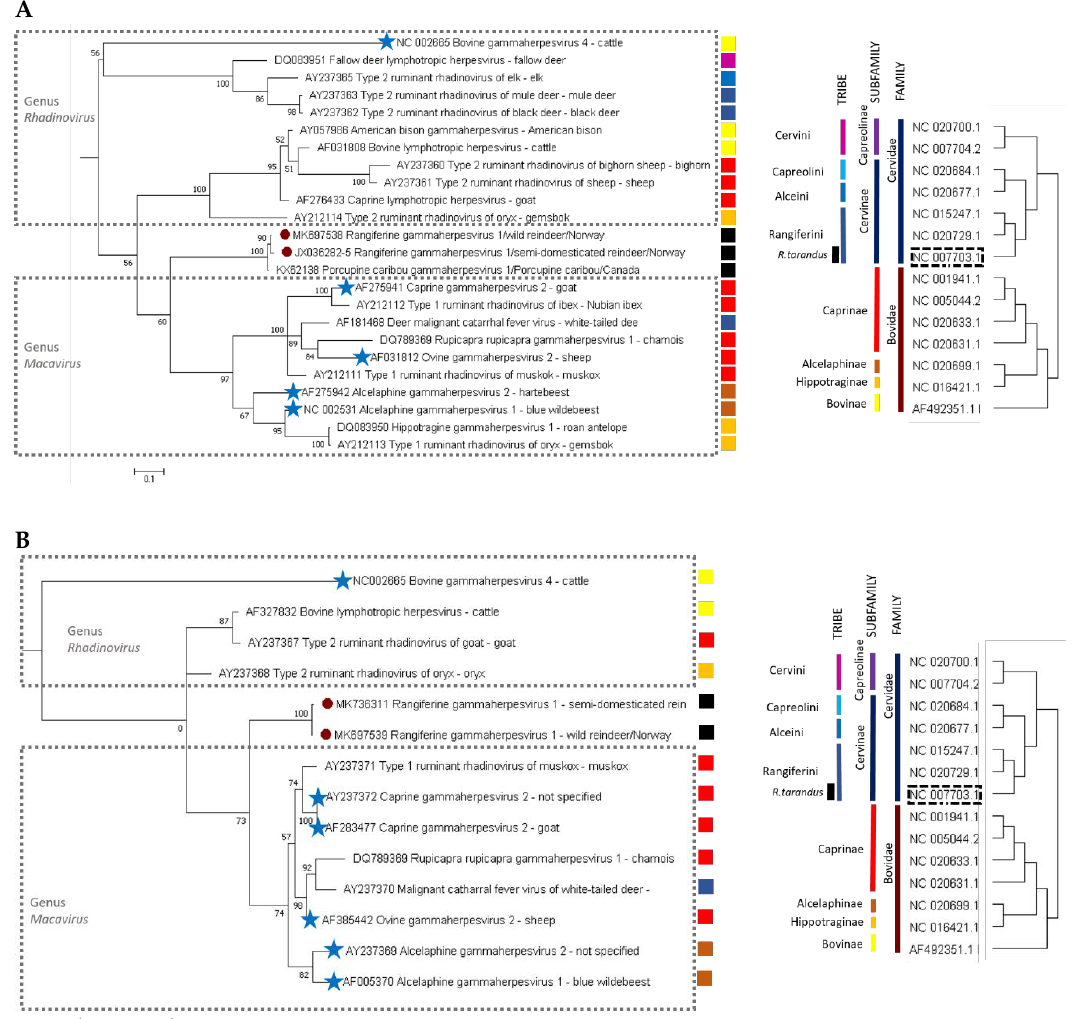
Figure A1. The information on the virus phylogenetic trees ( A , B ) is already presented in Figure 3. In front of each viral sequence, a colored rectangle refers to the taxonomic classification of its host species. These colors are explained on the right-hand side of the figure in an evolutionary cladogram based on species within the Cervidae and Bovidae families. Colored bars indicate the families, subfamilies, and tribes relevant to host species of viral sequences analyzed in this paper. The sequence referring to reindeer is highlighted in a black dashed box. The evolutionary relationships of taxa were inferred using the minimum evolution method [48]. The optimal tree with the sum of branch length = 0.91536236 is shown. The evolutionary distances were computed using the maximum composite likelihood method [49] and are in the units of the number of base substitutions per site. The ME tree was searched using the close-neighbor-interchange (CNI) algorithm at a search level of 1. The analysis involved 14 complete mitochondrion genome sequences (average of 16,000 bp). All positions containing gaps and missing data were eliminated. There was a total of 11,199 positions in the final dataset. Evolutionary analyses were conducted in MEGA7 [32]. For information on the ascension numbers used on the taxa cladogram, please refer to Table A1.